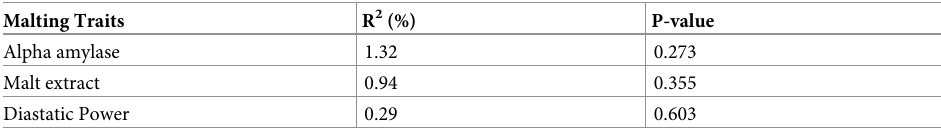
Table 4. The proportion of variation (%) shared between the malting traits of S x M mapping population. Malting